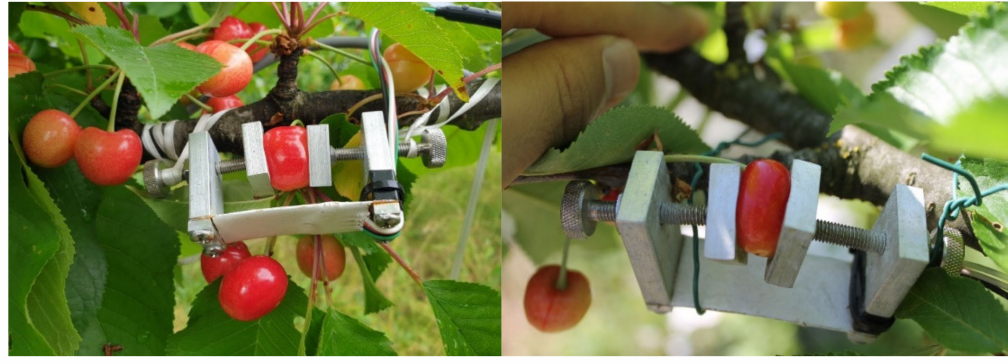
Figure 6. Cherry fruits on 28 May 2019 (DOY 148, left ) and 22 May 2020 (DOY 143, right ).